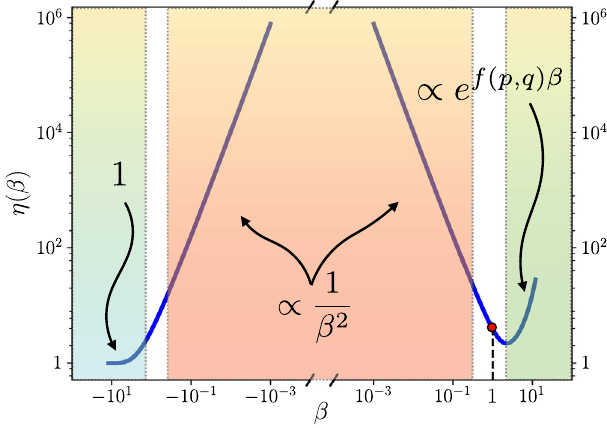
Figure 7 graphs η ð β Þ , revealing how it divides into three distinct scaling regimes.